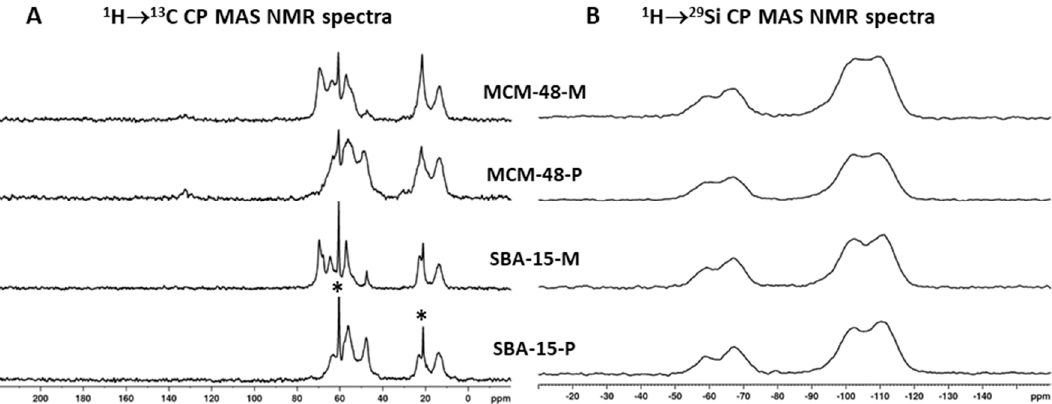
Figure 3. 1 H → 13 C ( A ) and 1 H → 29 Si ( B ) CP MAS NMR spectra of SBA-15-P, SBA-15-M, MCM-48-P, MCM-48-M; (the sharp resonances indicated with * originate from the residual unre-acted NEt3).